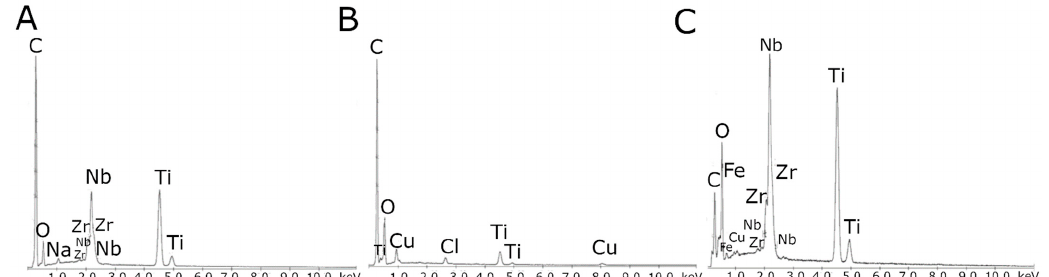
Figure 3. EDS spectra of the ( A ) MWCNTs reference coating, ( B ) MWCNTs/TiO 2 bi-layer coating, ( C ) MWCNTs_Cu dispersion coating.